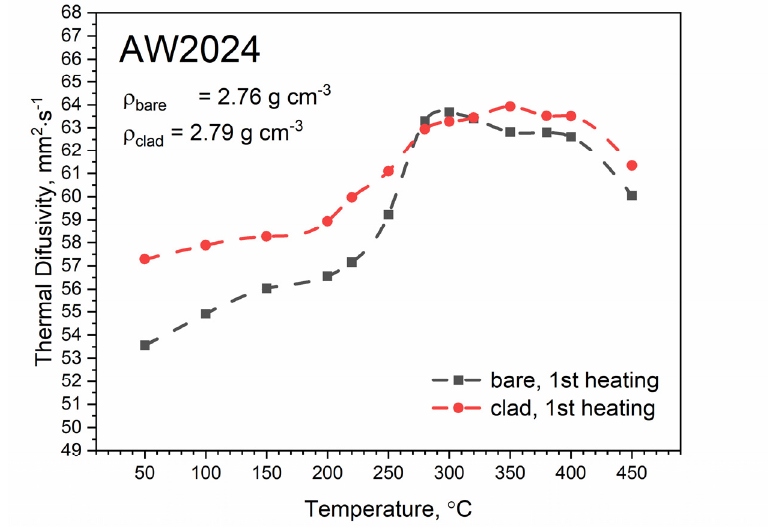
Figure 11. Thermal diffusivity as a function of temperature for bare and clad AW-2024-T3 alloys obtained from the first heating run on light flash apparatus (LFA) 467.